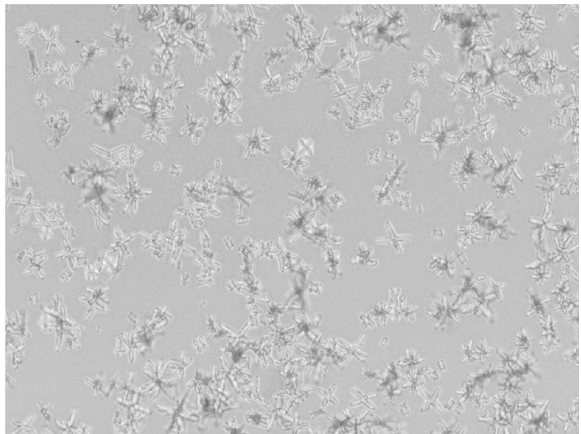
Figure 4 – Multiple crystalline aggregates, with increased volume and different habit.